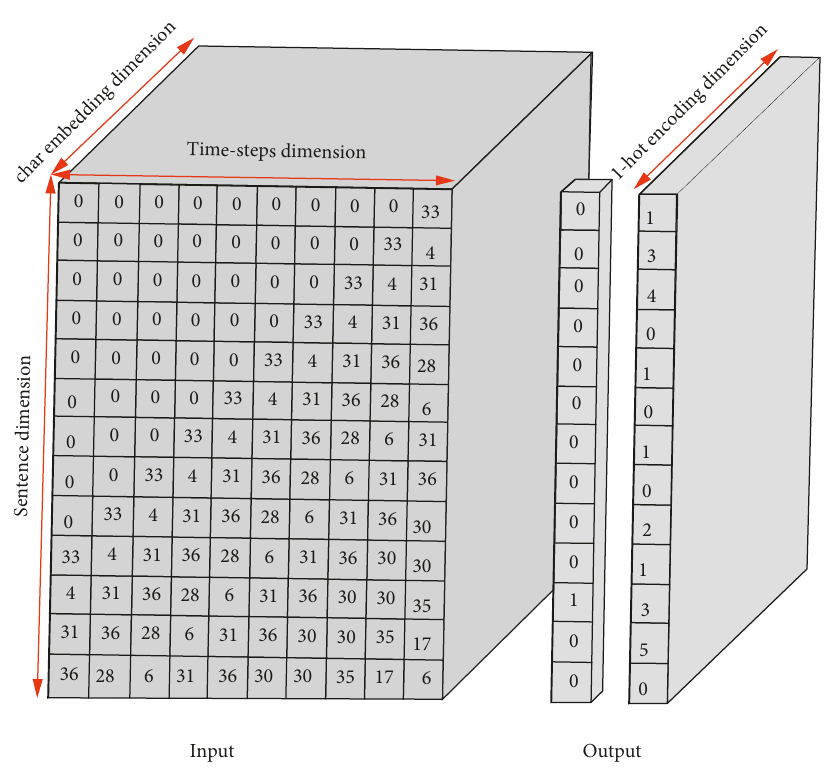
Figure 3: Input and output tensors in the proposed modification.